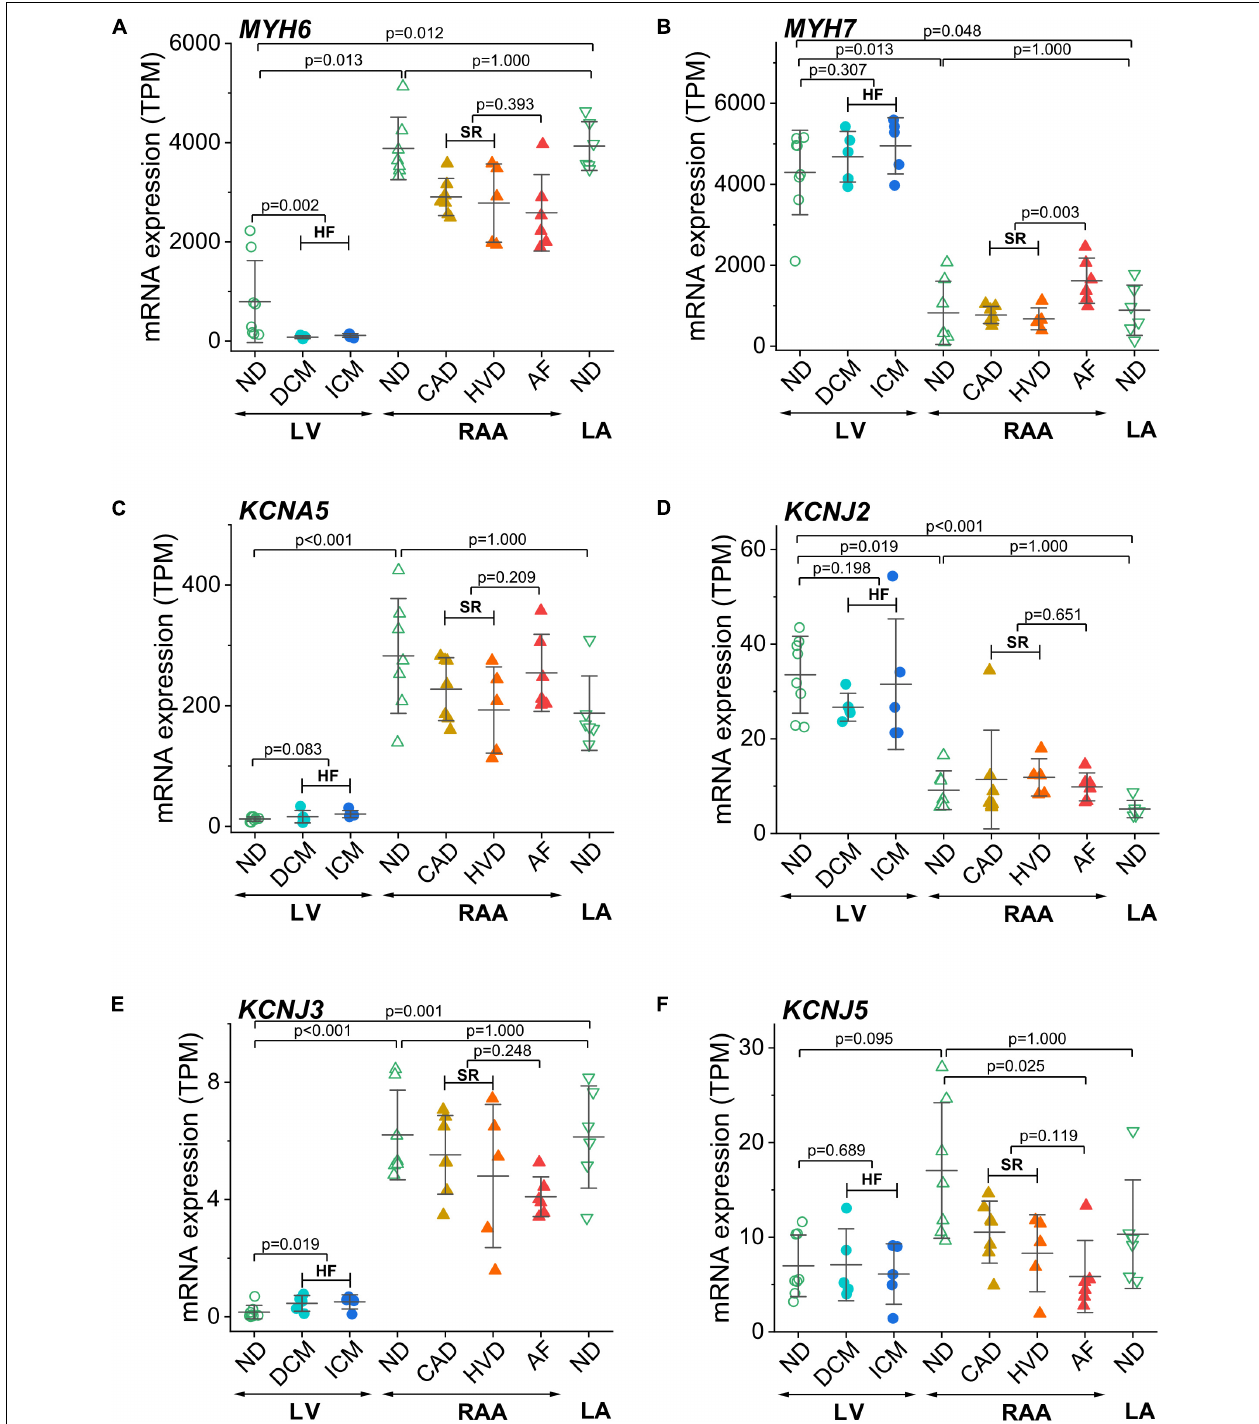
FIGURE 3 | Control of chamber identity and reproducibility of known chamber-selective gene expression in transcripts per kilobase million (TPM) assessed by RNA-seq. (A) MYH6 (myosin heavy chain 6), (B) MYH7 (myosin heavy chain 7), (C) KCNA5 (K v 1.5 or I Kur channel), (D) KCNJ2 (K ir 2.1 or K + voltage-gated channel subfamily J member 2), (E) KCNJ3 (GIRK1 or K ir 3.1 or K + inwardly rectifying channel subfamily J member 3), (F) KCNJ5 (GIRK4 or K ir 3.4 or K + inwardly rectifying channel subfamily J member 5). Sample provenance and patient’s health status as in Figure 2 . Heart failure (HF): pooled data from DCM and ICM; sinus rhythm (SR): pooled data from CAD and HVD. The mean ± SD data are represented. Statistical significance was assessed by Dunn’s test. For HF and SR, statistical significance was assessed by the Mann–Whitney test.